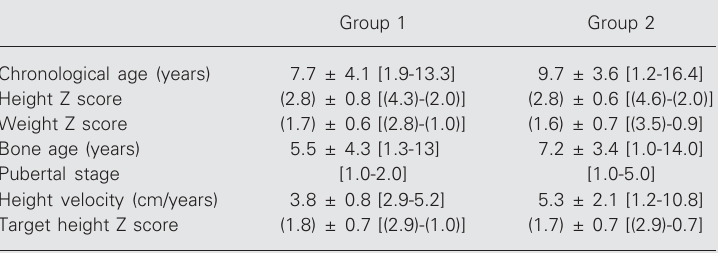
Table 1. Clinical data of patients with short stature with active or potential celiac disease (group 1) and patients with short stature of undetermined cause (group